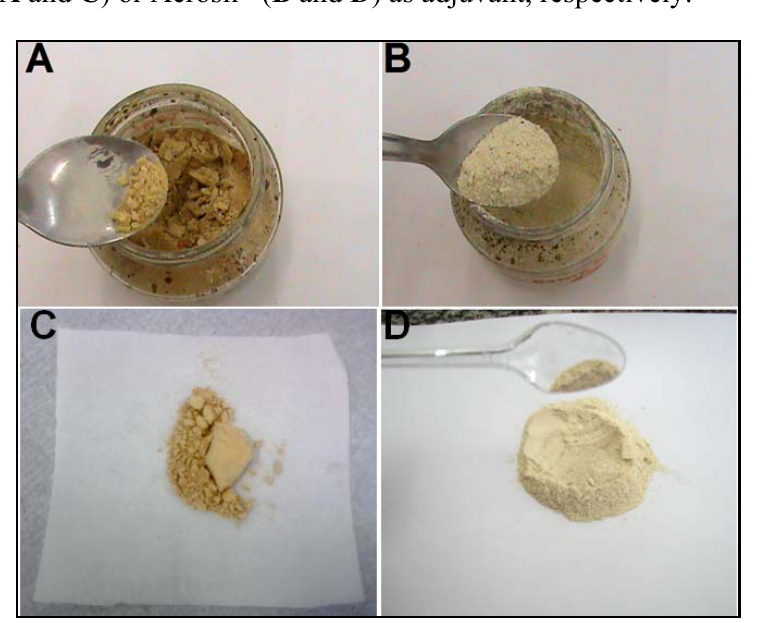
Figure 1. Guaco lyophilized ( A and B ) and atomized ( C and D ) extracts using maltodextrin ( A and C ) or Aerosil ® ( B and D ) as adjuvant,